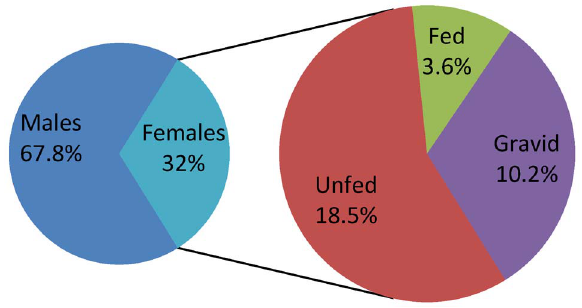
Figure 1. Cumulative distribution of Phlebotomusargentipes by sex and by feeding status among females.